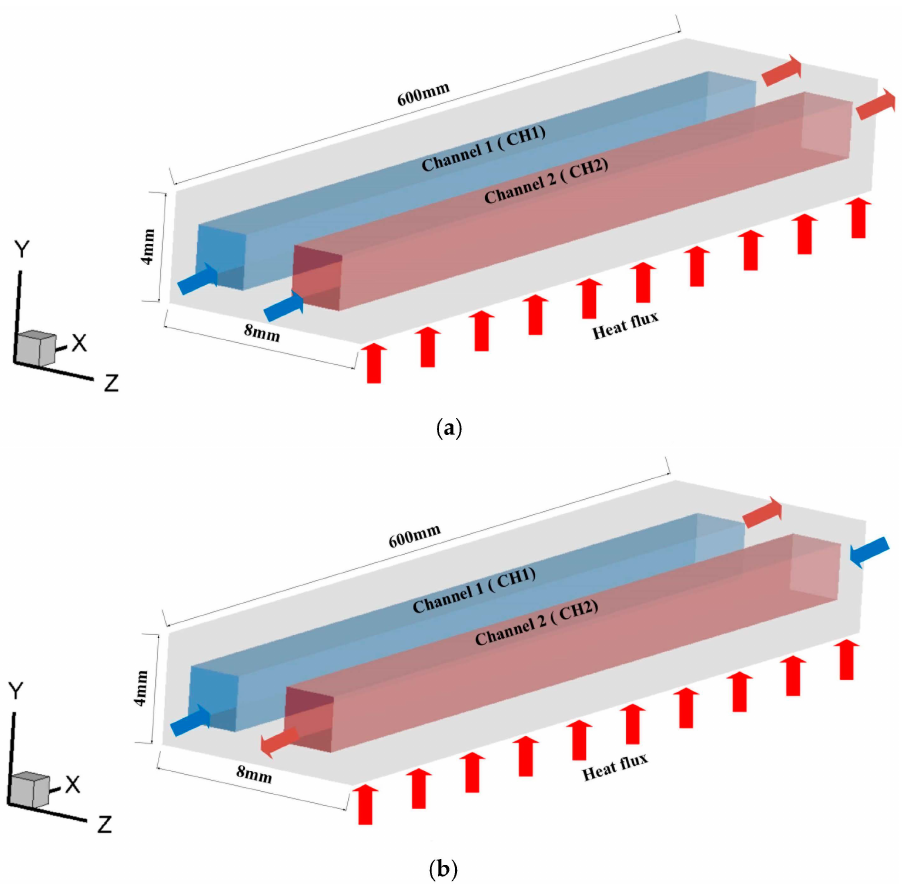
Figure 2. Computational domain in this paper: ( a ) case A: cooling channels with the same flow direction; ( b ) case B: cooling channels with opposite flow